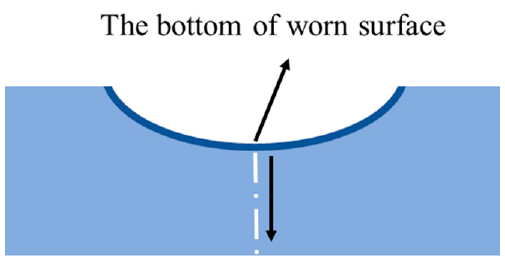
Figure 1. Schematic of microhardness test of the CoCrAlYTa-10%Al 2 O 3 coatings and H13 steel.